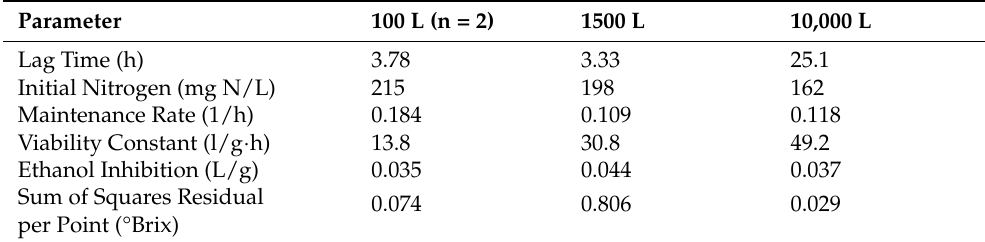
Table 3. Fermentation parameters of controlled redox potential fermentations across